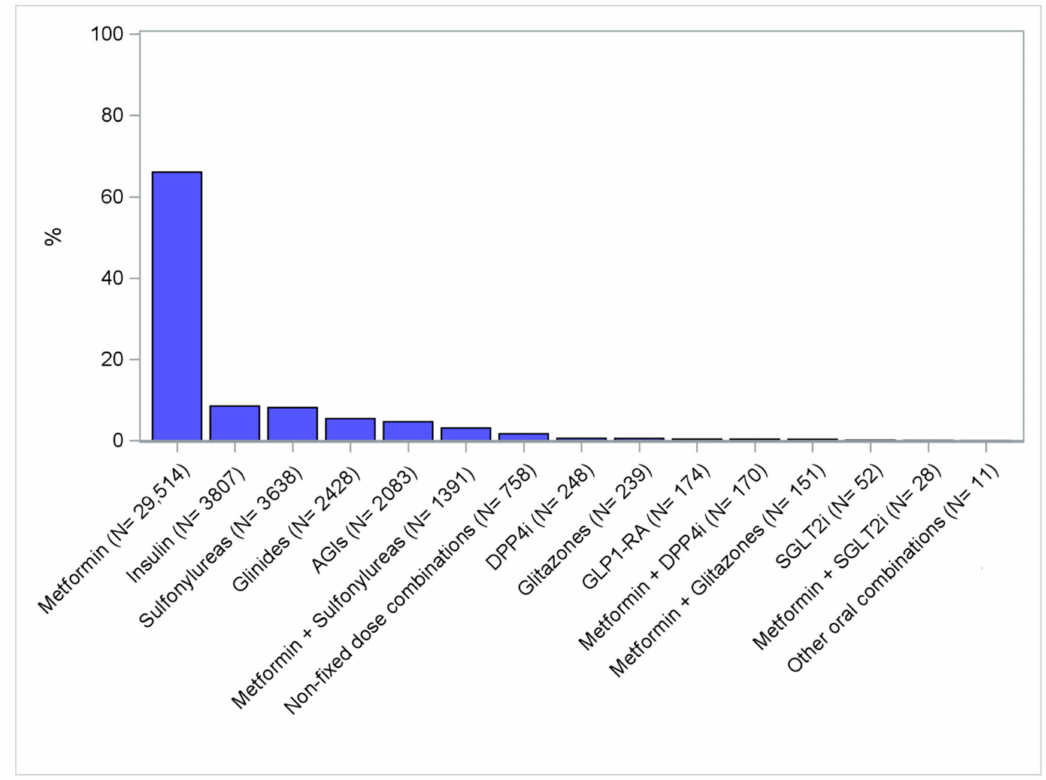
Figure 2. Distribution (%) of the first antidiabetic drug use, stratified by antidiabetic molecule / class. Legend: AGI = alpha-glucosidase inhibitors; DPP4i = dipeptidyl peptidase-4 inhibitors; GLP-1RA = glucagon-like peptide-1 receptor antagonists; SGLT2i = sodium–glucose linked transporter 2 inhibitors; Other oral combinations = fixed-dose combinations of glitazones + DPP4i and glitazones +